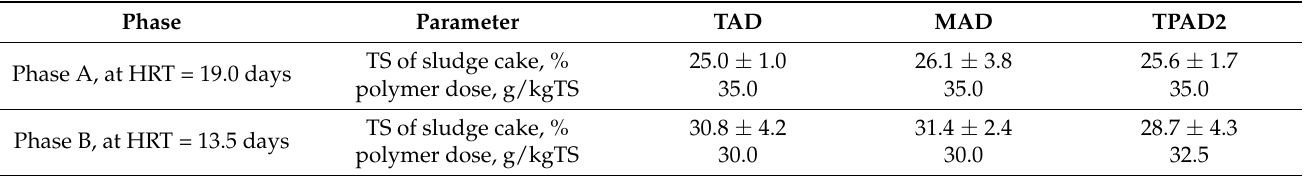
Table 7. The results of mechanical